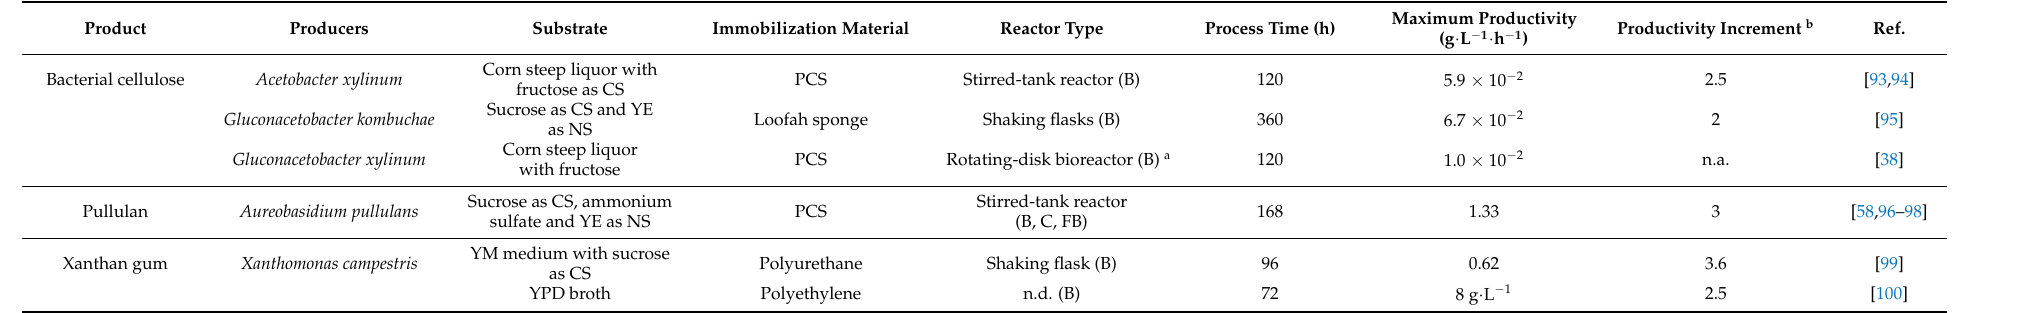
Table 3. Different classes of polysaccharides produced in biofilm